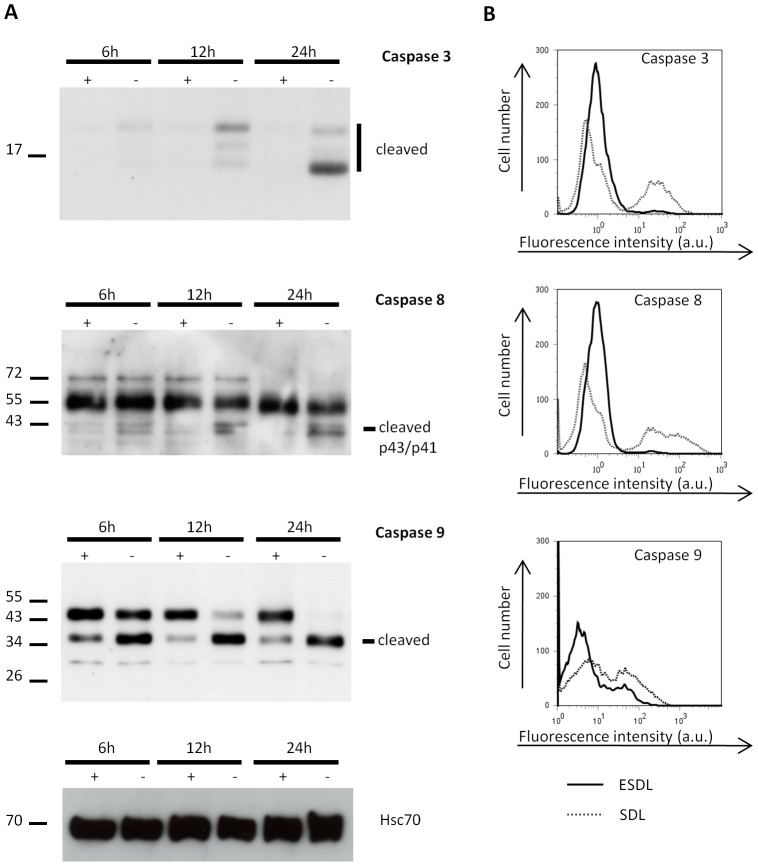
Caspase activation after Epo removal.Western blotting (A) of total cell lysates from one independent culture, harvested after 6 hour, 12 hour and 24 hour in ESDL (+Epo) and SDL (-Epo) using an antibody against cleaved caspase 3, caspase 9, caspase 8, and hsc70 was used as a loading control. 20 µg of protein lysate was loaded in each well (B) Flow Cytometry analysis of active caspase 8, active caspase 3 and active caspase 9 for ESDL (thick black line) grown cells and SDL (dotted grey line) after 24 hours. Active caspase 9 was detected on a separate culture from the caspase 3 and caspase 9 and using a different flow cytometer.